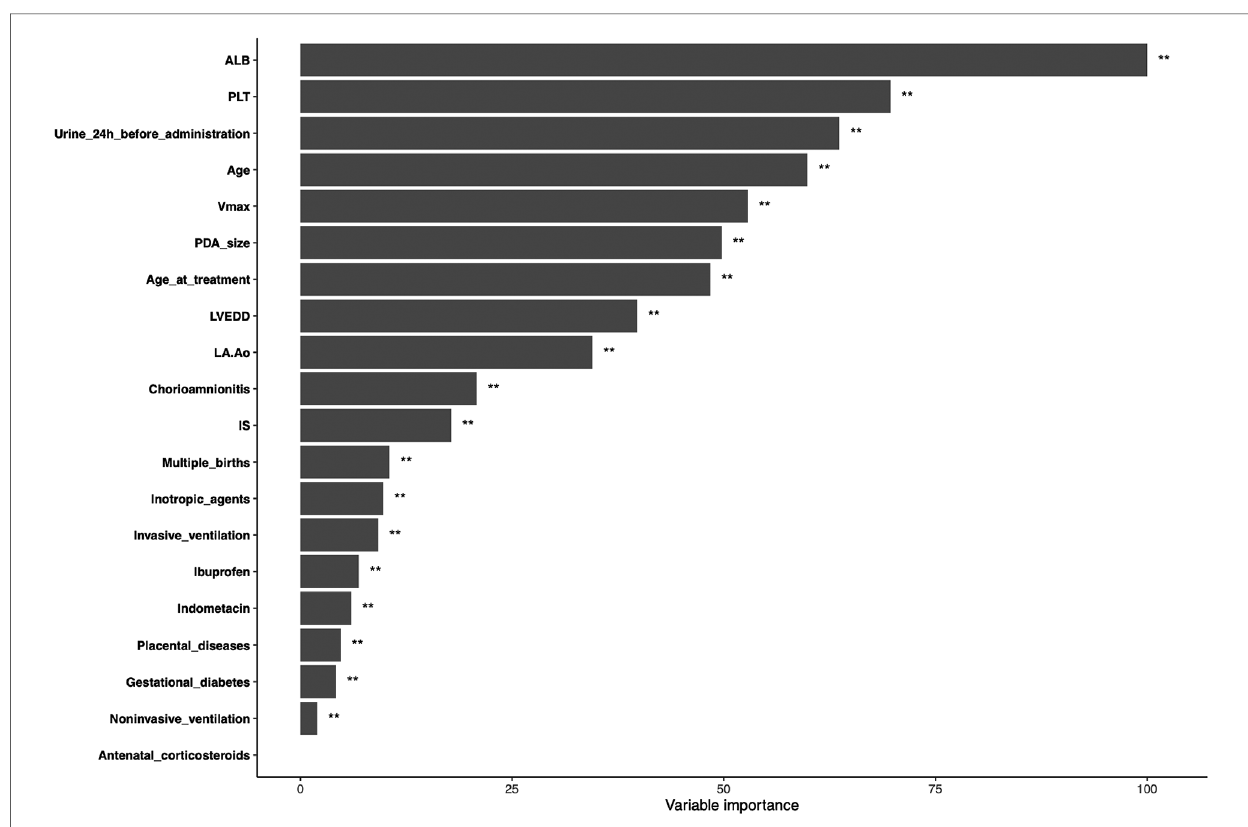
FIGURE 3 Variable importance of proposed model. ALB, albumin; PLT, platelet; Age, gestational age; Vmax, maximum systolic velocity across the ductus arteriosus; PDA, patent ductus arteriosus; LVEDD, left ventricular end-diastolic diameter; LA:Ao, left atrial-to-aortic-root diameter ratio; IS, inotropics